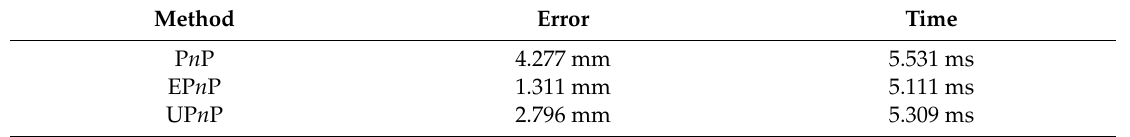
Table 2. Comparison of di ff erent camera pose estimation